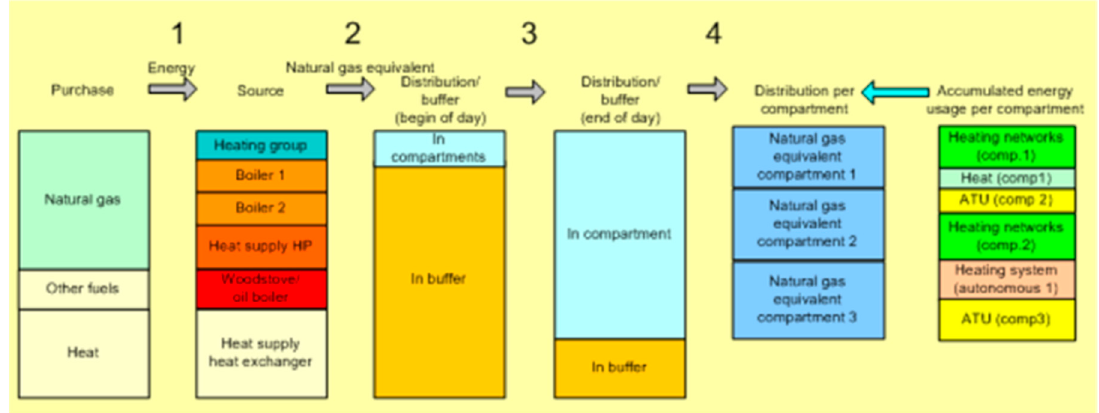
Figure A1. Electrical panels and power distribution.